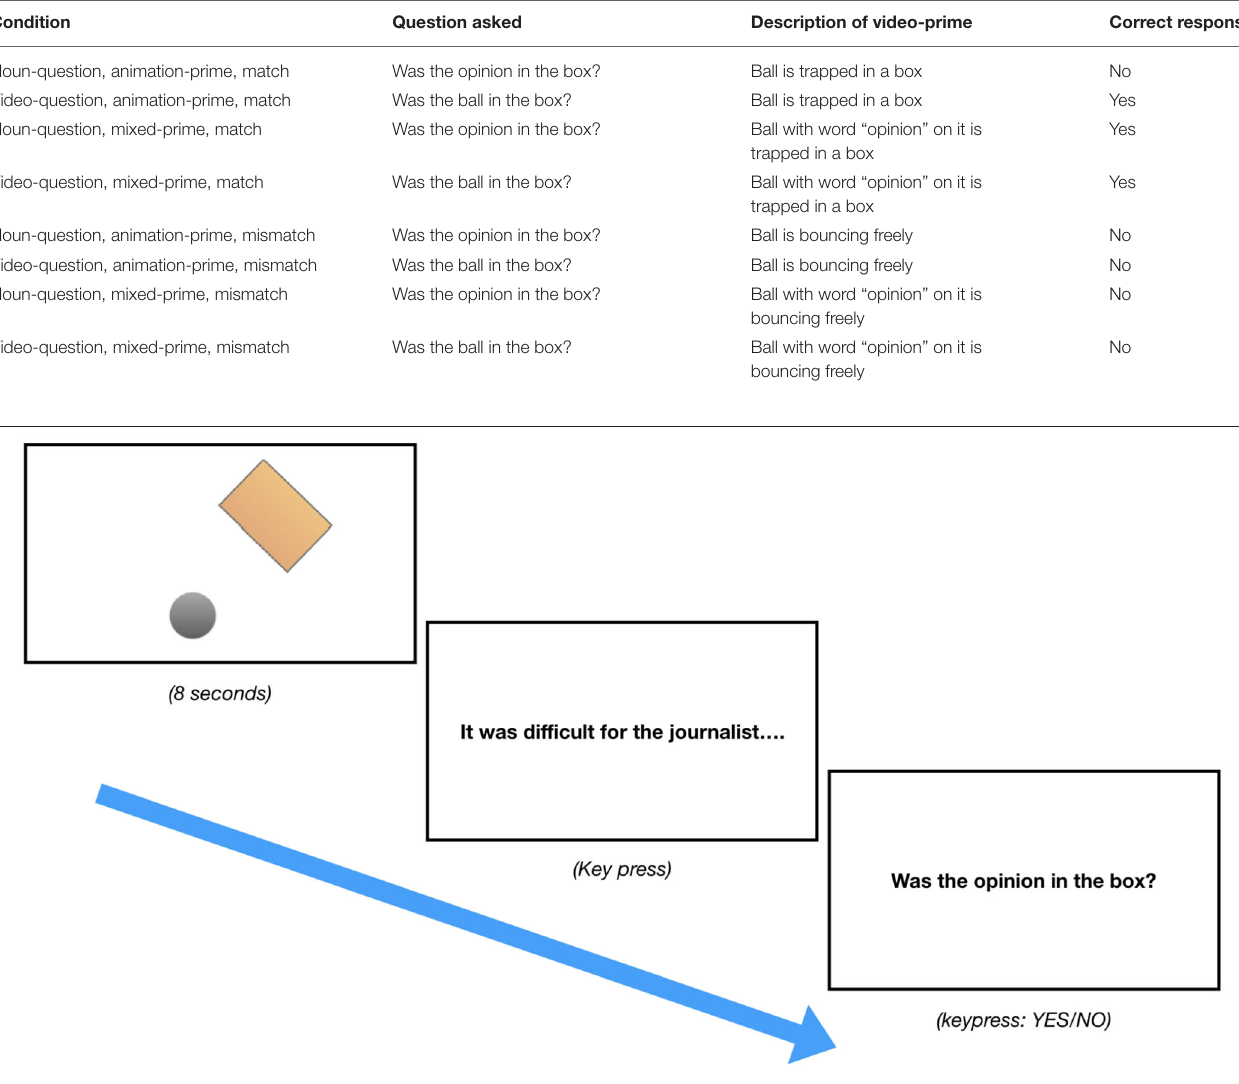
FIGURE 2 | Example of the progression of a trial in experiments